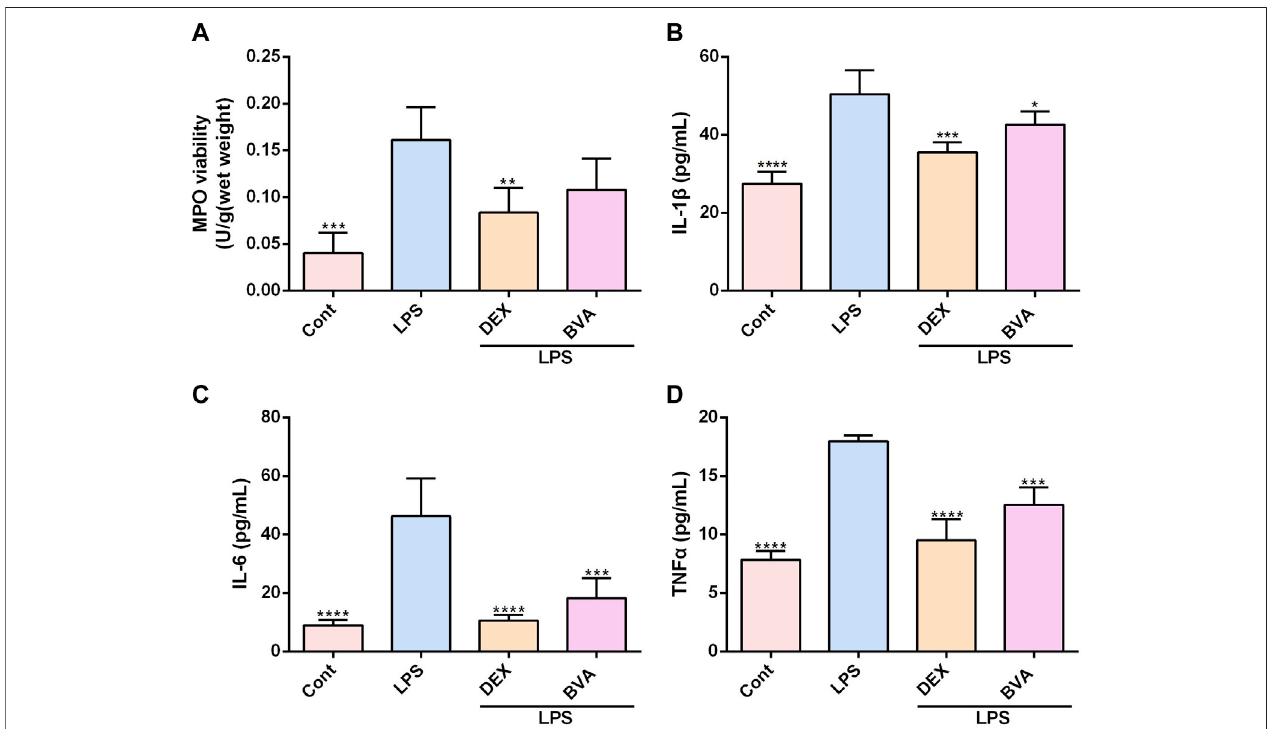
FIGURE3| BrevilinAinhibitsMPOactivityandsynthesisofcytokinesinLPS-challenged mice.AfterLPSexpose,miceweretreatedwithBVA,DEX,orvehicle.The lungtissueswereusedtodetect theactivity ofMPO (A) .Theserums werecollectedtoexaminethelevelsofIL-1 β (B) ,IL-6 (C) ,andTNF α (D) usingELISAkits.* p < 0.05, ** p < 0.01, *** p < 0.001, **** p < 0.0001, vs.